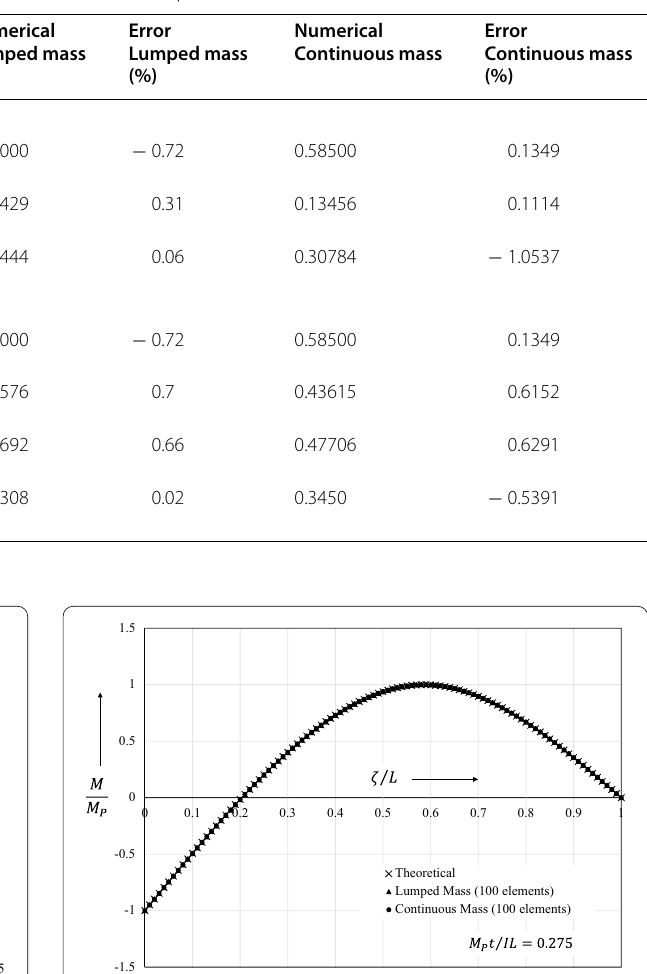
Table 1 Comparison between theoretical solution and numerical LCP solution at phase transition.